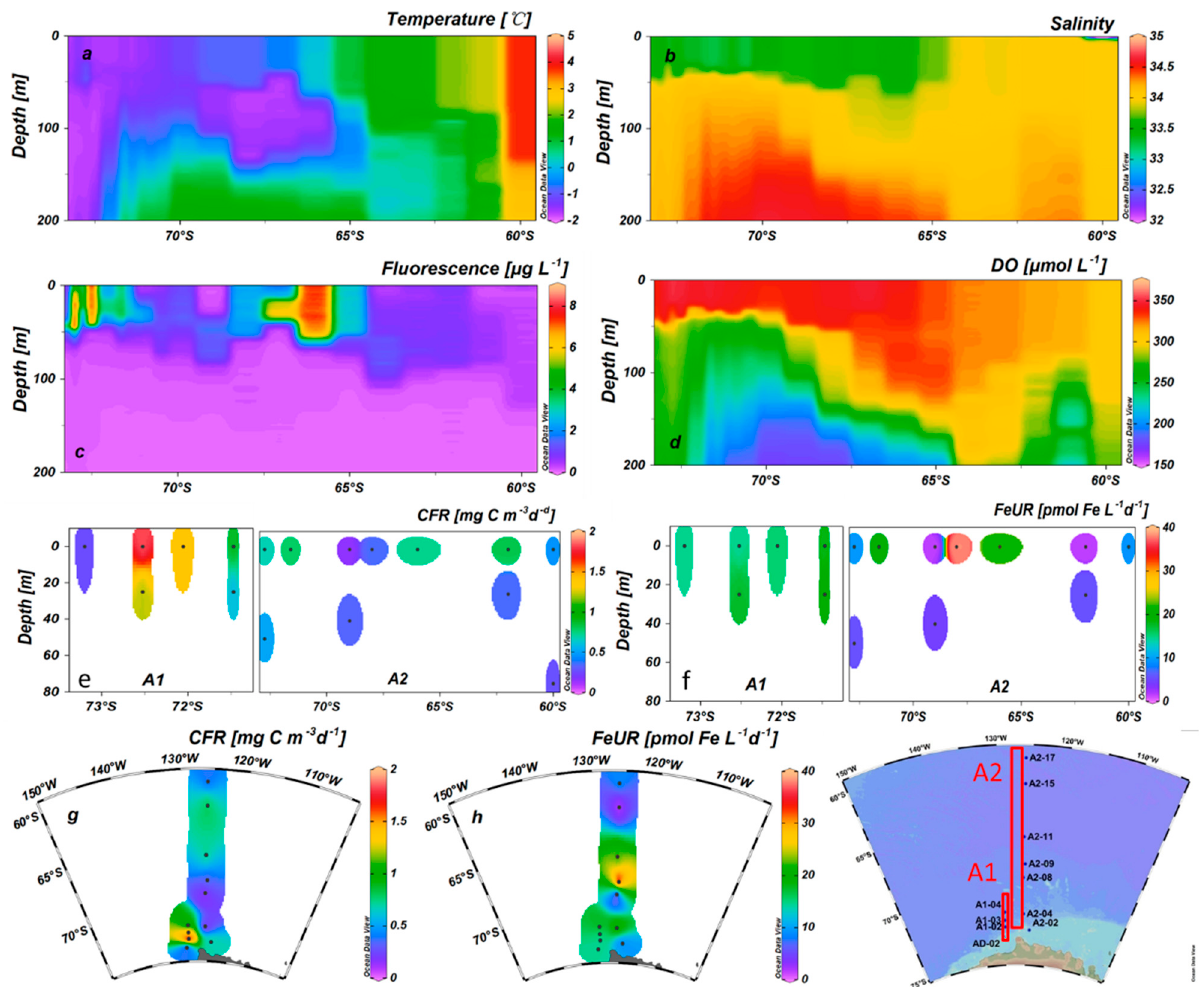
Figure 3. The distribution of the temperature ( ° C) ( a ), salinity (psu) ( b ), fluorescence ( μ g L – 1 ) ( c ), DO ( μ mol L – 1 ) ( d ), CFR (mgC m – 3 d – 1 ) ( e ), and FeUR (pmolFe L – 1 d – 1 ) ( f ) values in sections A1 and A2 and the CFR (mgC m – 3 d – 1 ) ( g ) and FeUR (pmolFe L – 1 d – 1 ) ( h ) distributions in the surface water. Note that only CFR and FeUR in the surface and CMD layers were determined.